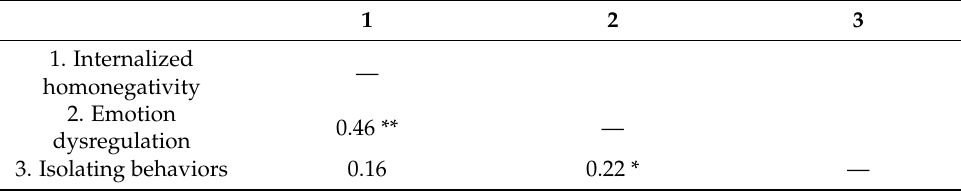
Table 3. Bivariate correlations between scale study